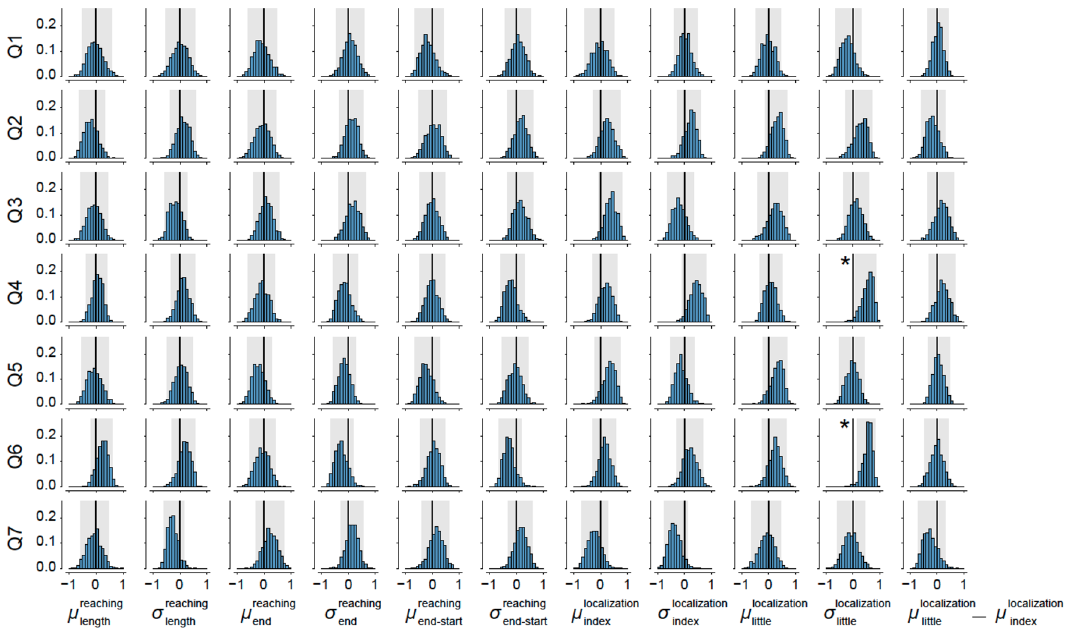
Figure 5. Bootstrap distributions of correlation values between differences across controllable and random conditions for questionnaire scores and post- and pre-habituation difference in behavioral measures. The black thick lines indicate zero correlation, and the gray shades indicate the range of correlation within which 95% of bootstrapped correlation values distributed for each combination of questions and behavior measures. The asterisks indicate correlation pairs whose 95% bootstrapped correlation distribution is not overlapped with zero